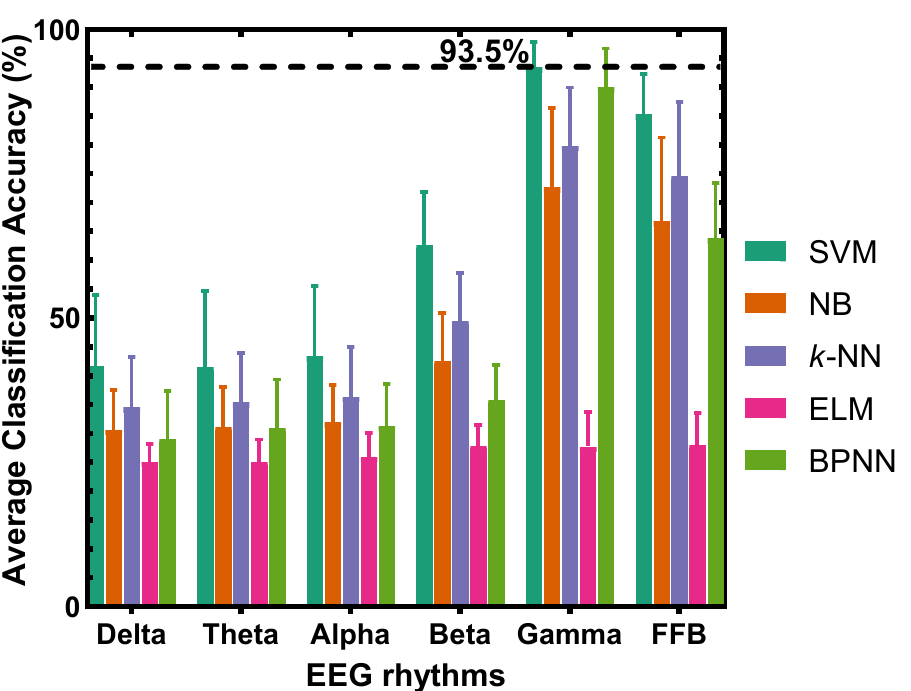
Figure 3. Classification results across concentrations of all participants on the five pleasant emotions induced by the rose odor.